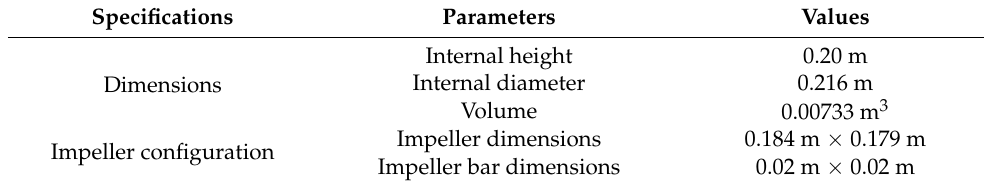
Table 2. Specifications of the